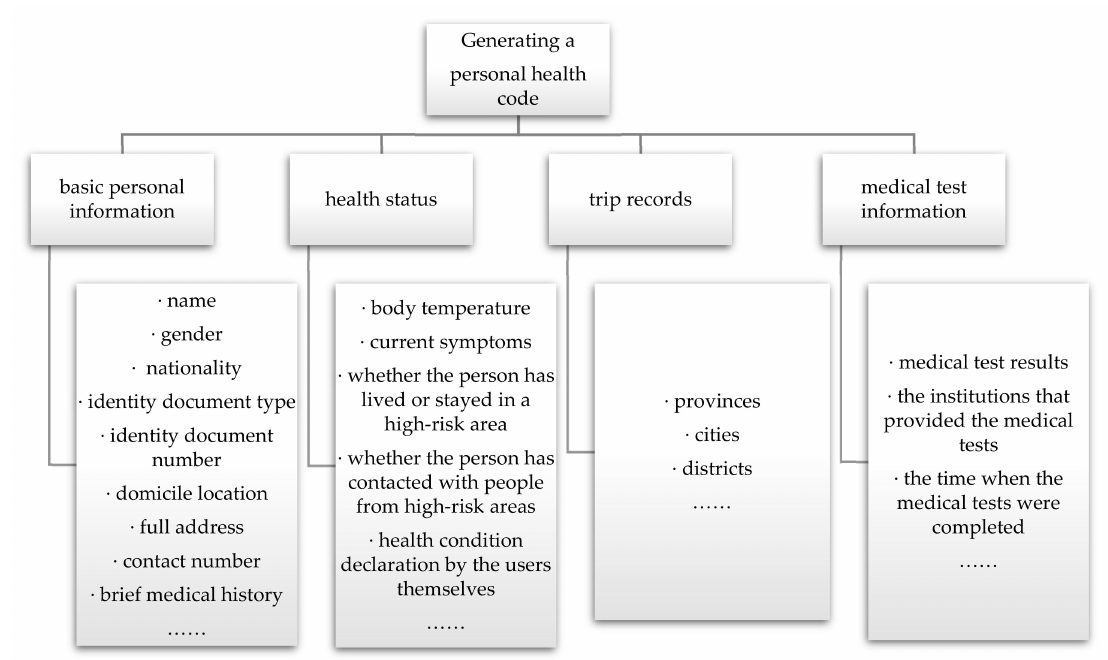
Figure 2. Categories of information required for generating a personal health